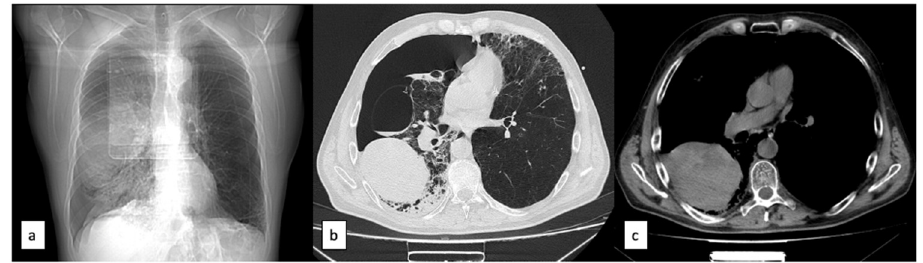
Figure 3. Scans indicate a right basal pneumothorax with opacification of bullous lesions: ( a ) X ray; ( b ) CT-lung window; ( c ) CT-chest window.